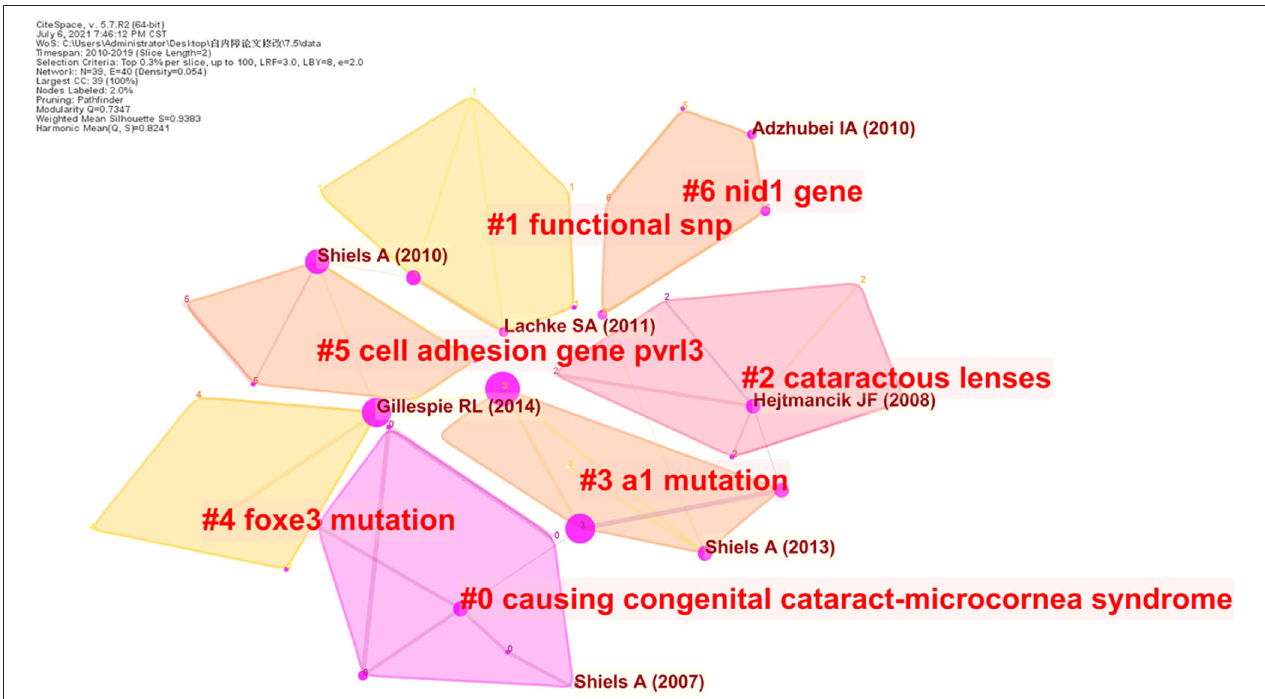
FIGURE 7 | Reference co-citation map of publications on Cataract-gene from 2010 to 2019.